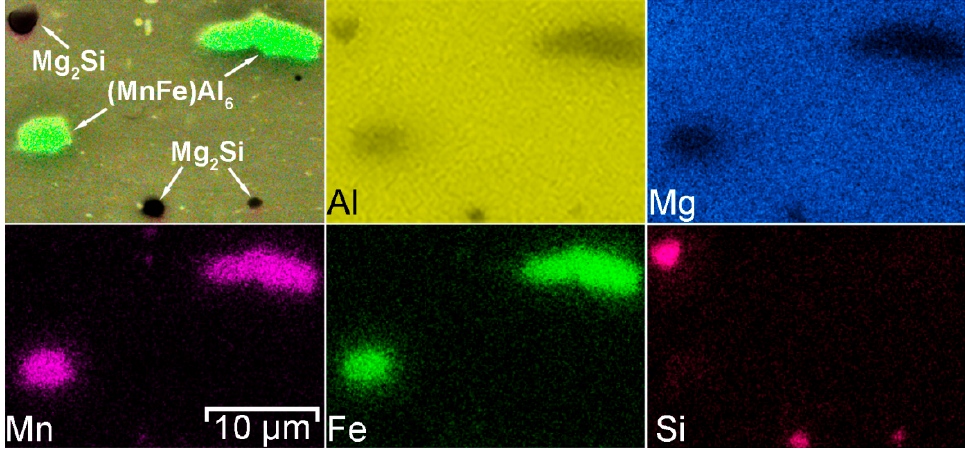
Figure 6. Element distribution in the HAZ. Presence of Mn-Fe-Al and Mg-Si phases was detected.